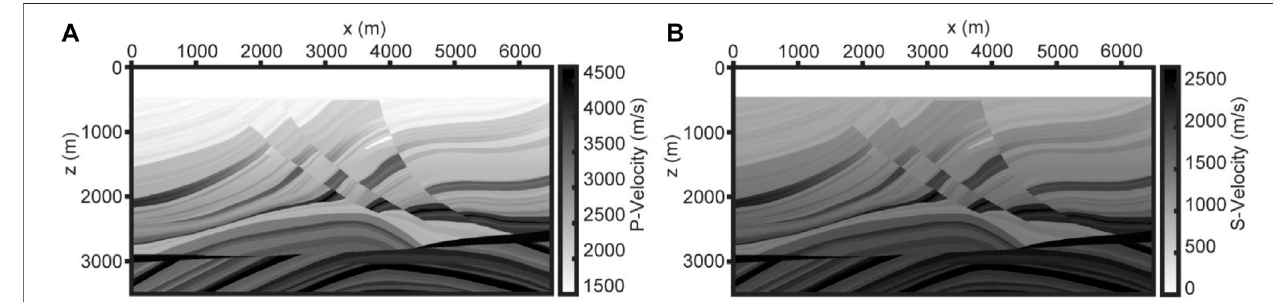
FIGURE 5 | Partial Marmousi2 velocity models of (A) P-wave and (B) S-wave.